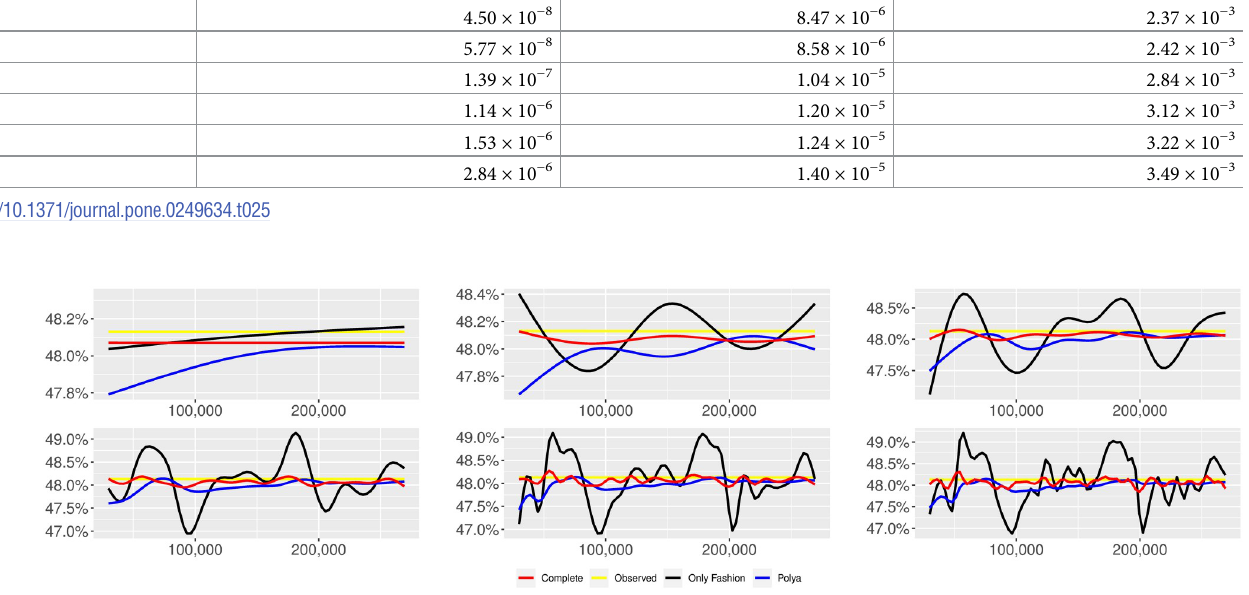
Fig 13. “Migration” ( T = 0.5, entire, D = 3 0 , S = 100 slots of equal size): Sentiment curves. In each panel, the yellow line is the cubic spline smoothing of the time series of the observed tweets ξ n +1 , together with the default confidence interval (gray), the red line represents the cubic spline smoothing of the time series of the estimated predictive means ^ c (defined in Subsec. 3.2), obtained with the complete RP model, the black and the blue lines provide n similar approximations obtained with the other models: black = Only fashion RP model and blue = Standard Po´lya model. In each panel, the smoothing is obtained with a given number of nodes: k = 3 (top left panel), 5 (top middle panel), 10 (top right panel), 20 (bottom left panel), 30 (bottom middle panel), 50 (bottom right panel).